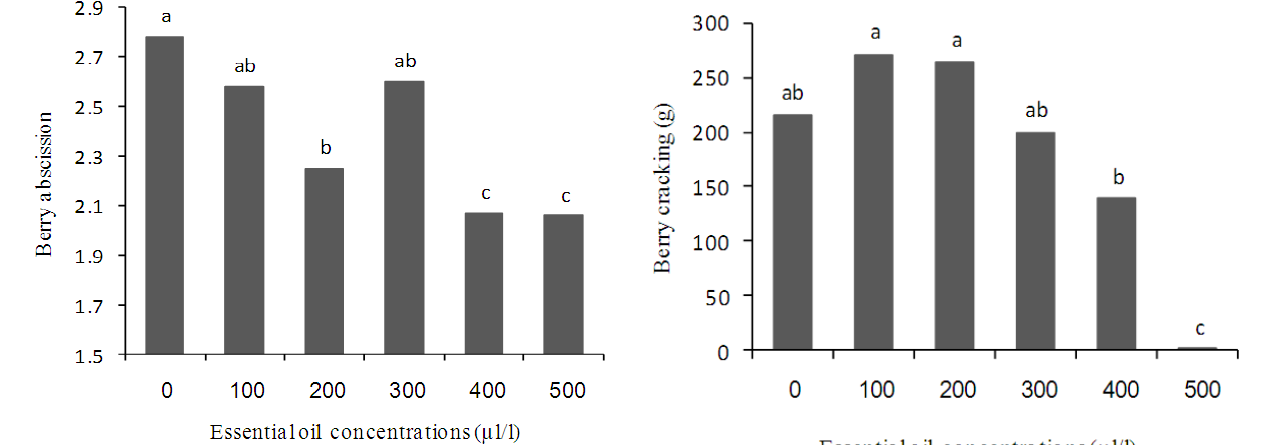
Fig. 8. The effect of essential oil treatment on berry abscission of ‘Bidaneh Qermez’ table grape